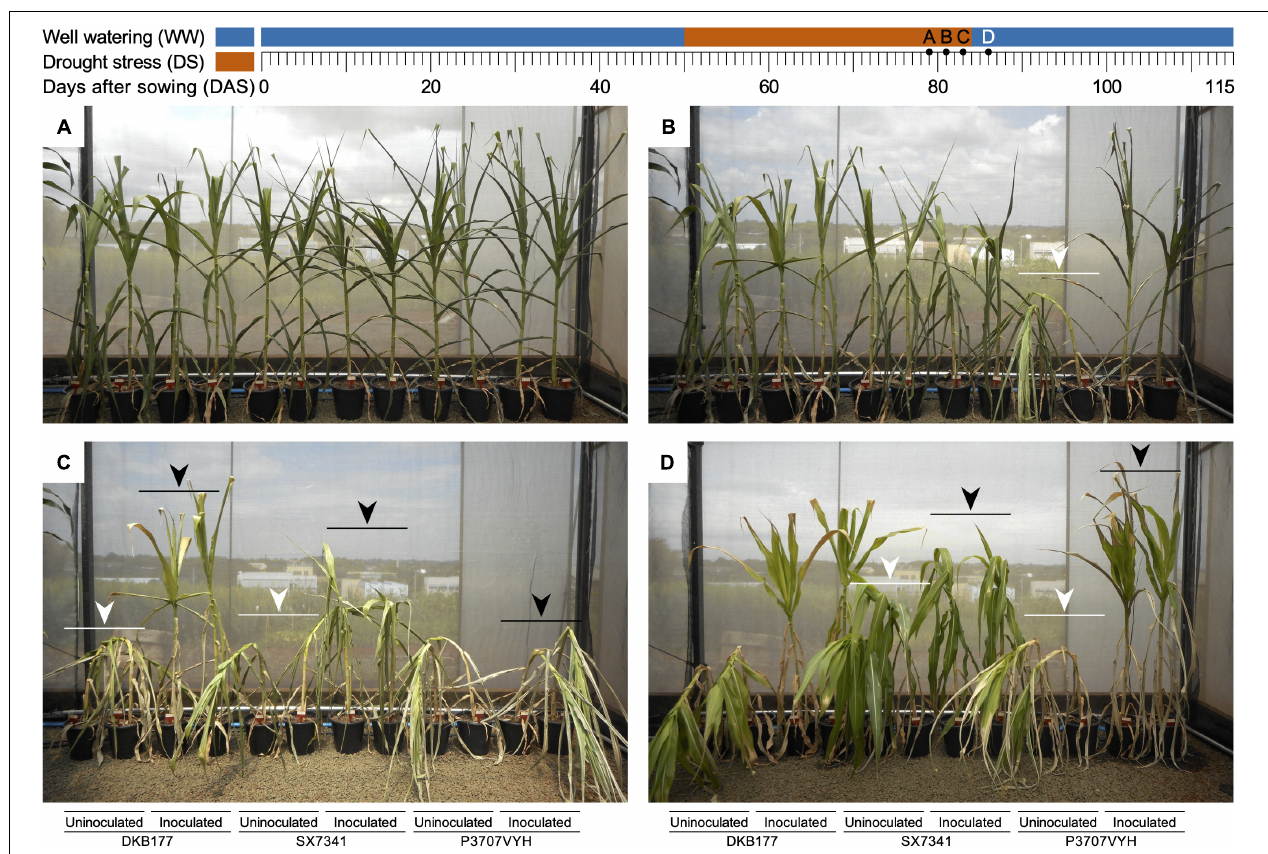
FIGURE 1 | A SynCom containing beneficial microbes induces a physiological response against DS in three commercial maize hybrids. (A) Plants kept in SDS for 29 days (79 DAS) had their leaves rolled inward, and older leaves fell for all hybrids, regardless of whether they were inoculated. (B) P3707VYH was the less tolerant hybrid in the absence of SynCom, completely bent after 31 days of SDS (81 DAS), in contrast to the inoculated hybrid (white arrow). (C) Uninoculated DKB177 and SX7341 were completely bent (83 DAS), as shown by the white arrows. In the presence of SynCom, plants were maintained in a straight position (DKB177) and partially or completely bent (SX7341 and P3707VYH, respectively), as shown by the black arrows. (D) Inoculated plants (SX7341 and particularly P3707VYH) straightened 2 days after rewatering (86 DAS; black arrows), while uninoculated plants were not capable of completely recovering their structure (white arrows). Detailed results are shown in Supplementary Figure 3 and Supplementary Movie 1 . WW, well watering; DS, drought stress; DAS, days after sowing; SDS, severe drought